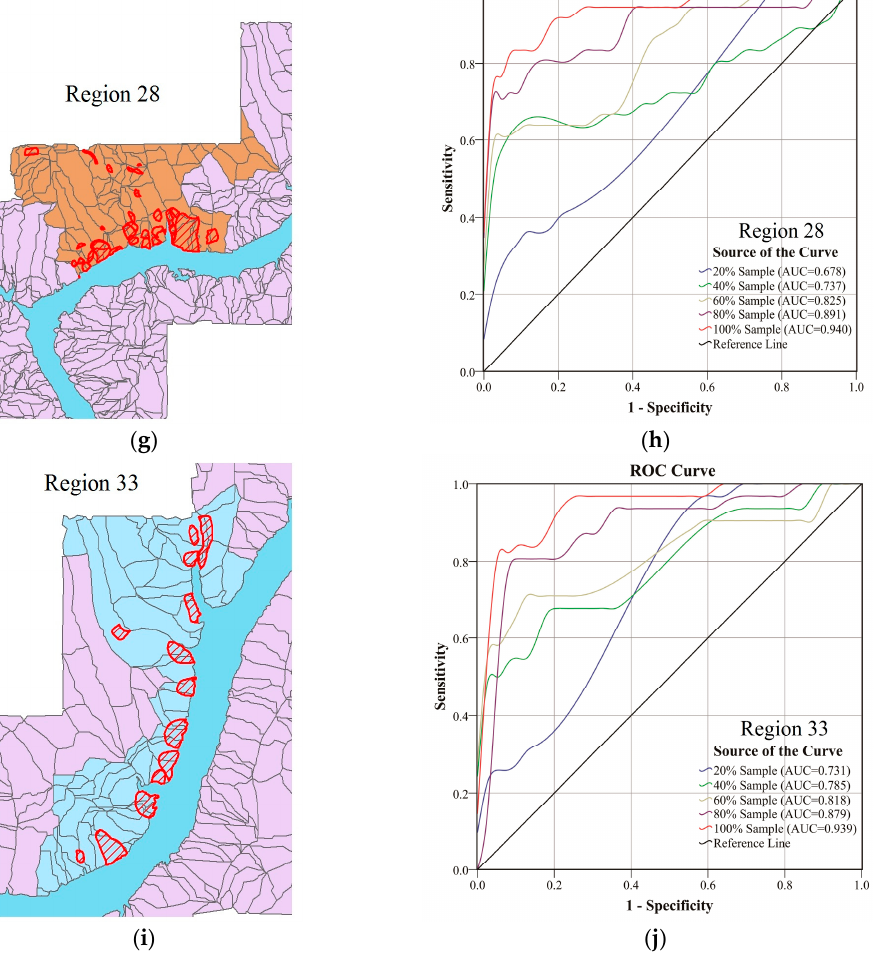
Figure 20. The ROC curves with different sample sets for the five regions. ( a ) The prediction region No. 9; ( b ) the ROC curves and AUCs corresponding to ( a ); ( c ) the prediction region No. 25; ( d ) the ROC curves and AUCs corresponding to ( c ); ( e ) the prediction region No. 26; ( f ) the ROC curves and AUCs corresponding to ( e ); ( g ) the prediction region No. 28; ( h ) the ROC curves and AUCs corresponding to ( g ); ( i ) the prediction region No. 28; ( j ) the ROC curves and AUCs corresponding to ( i ).